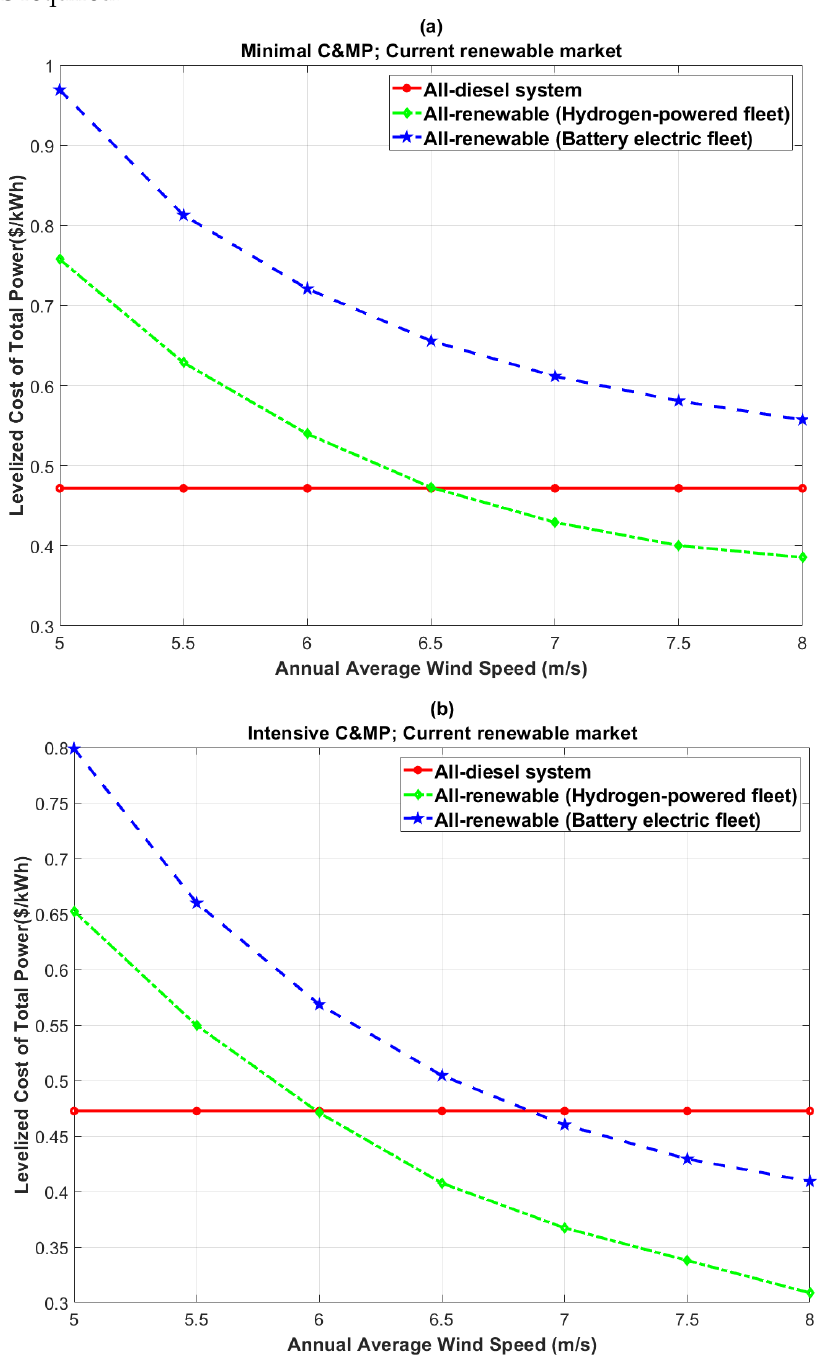
Figure 11. Wind speed impact on all-renewable system (Battery and FC storage config.) with the current renewable market: ( a ) surface mine with minimal C&MP; ( b ) surface mine with intensive C&MP.